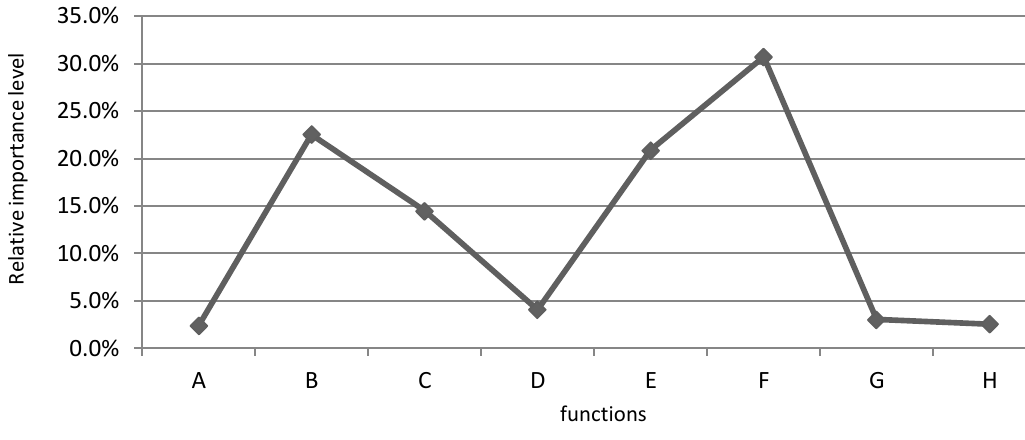
Figure 4. The median line of Mudge diagrams completed by all